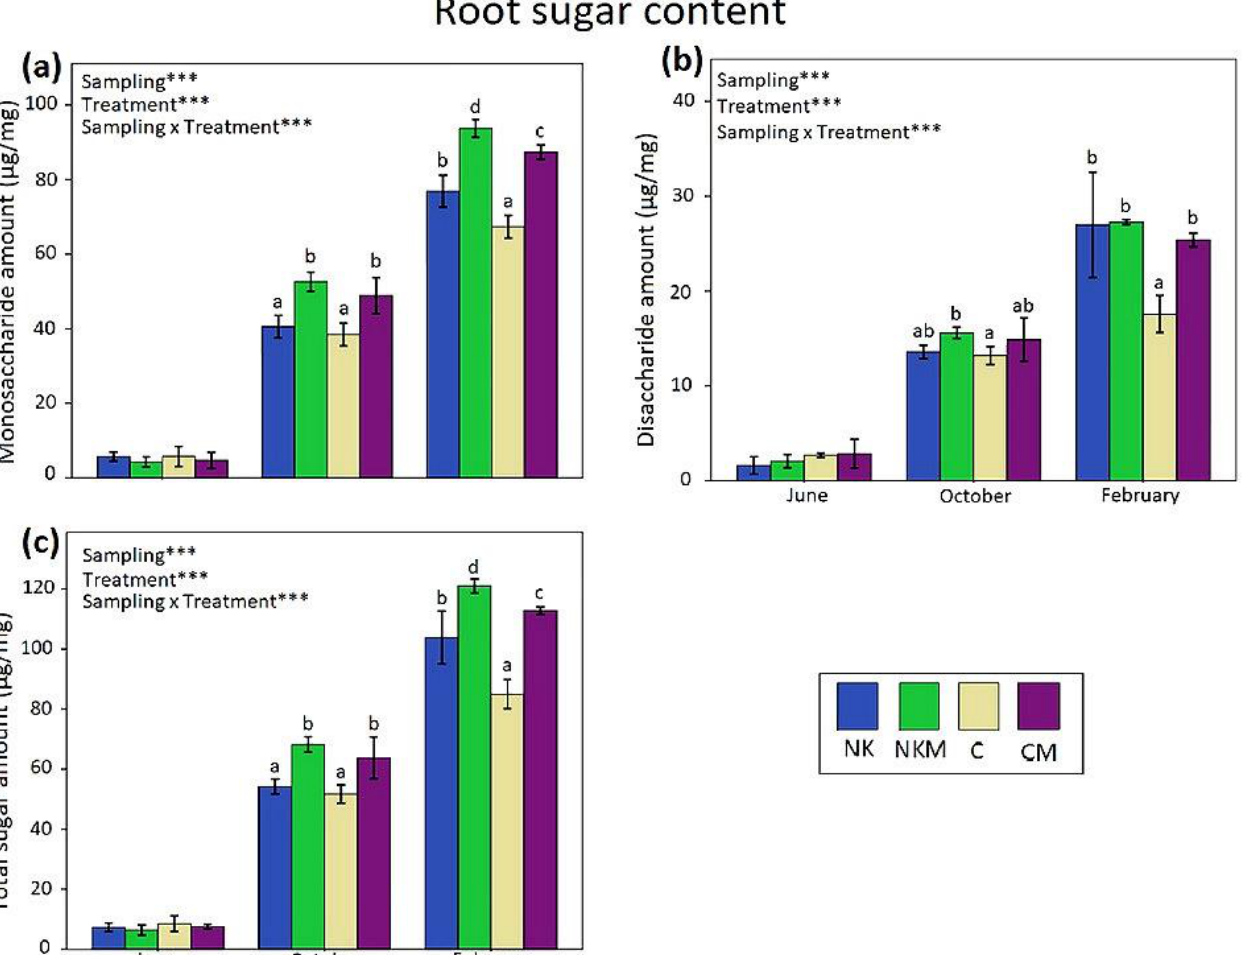
Figure 4. ( a – c ) Mean values ( ± SE) of root monosaccharide ( a ), disaccharide ( b ) and total sugar ( c ) content, as recorded in July, October and February samplings of all treatment groups (NK: KNO 3 fertilizer; NKM: KNO 3 in combination with PGPR; C (Control): NH 4 NO 3 fertilizer and CM: NH 4 NO 3 fertilizer in combination with PGPR). “Sampling”, “Treatment” and “Sampling × Treatment” on the top of the graphs indicate a significant effect of the sampling period, the treatment or their interactive effect, respectively, as revealed by ANOVA (*** p < 0.001). Different superscript letters denote significant differences between treatments (a: corresponds to the lowest